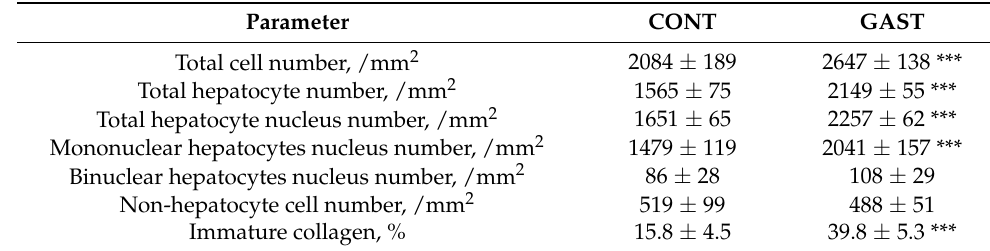
Table 3. The histomorphometrical parameters of the liver in male Wistar rats in the CONT (sham- operated) and GASTR (subjected to gastrectomy)